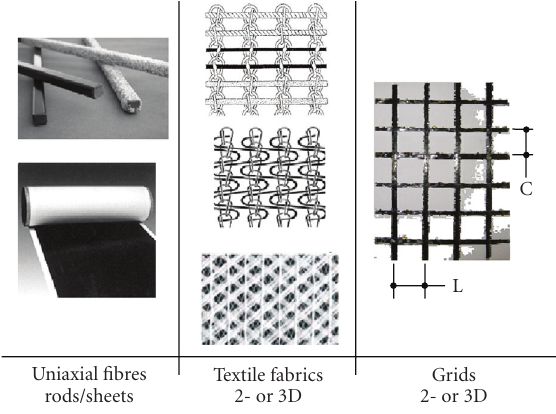
Figure 3: Di ff erent types of fibre